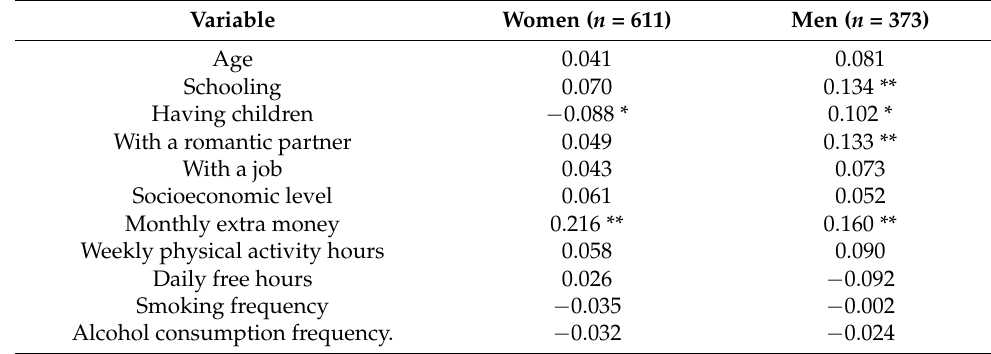
Table 3. Correlations between cognitive active coping with the sociodemographic